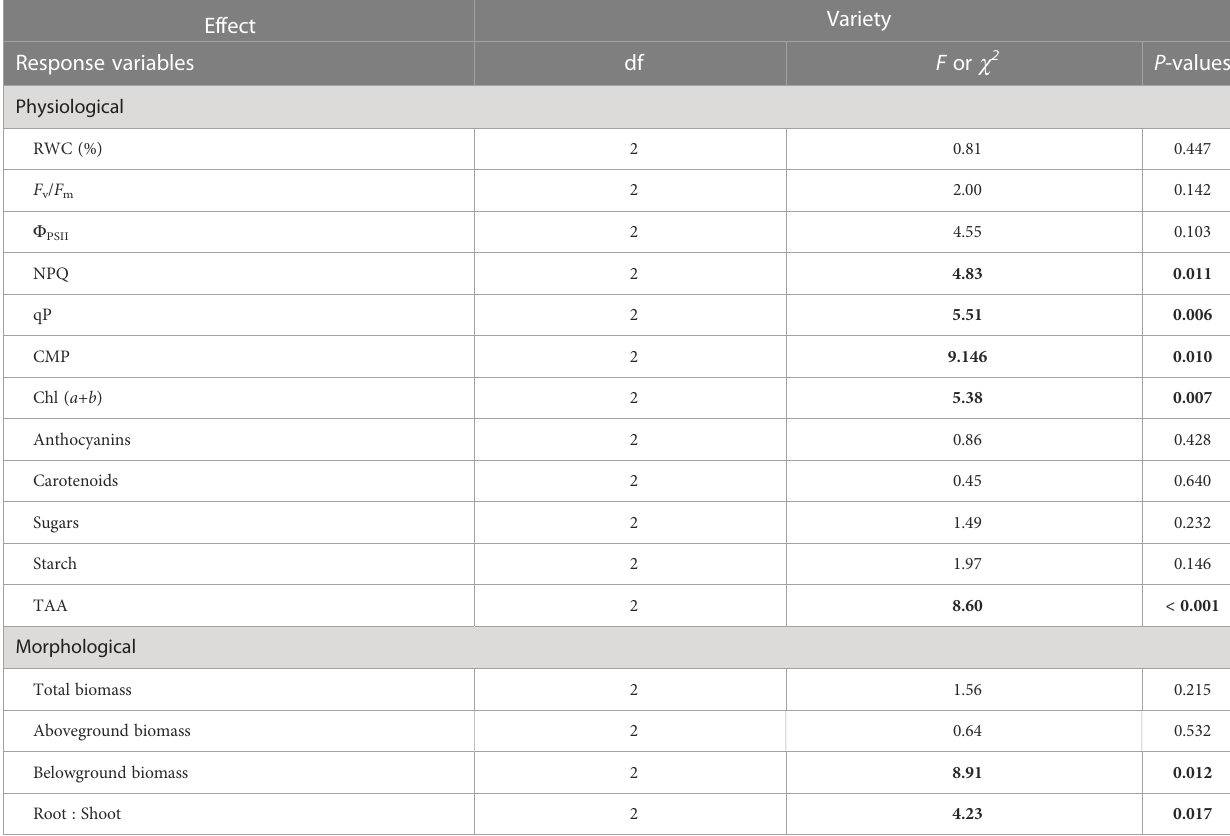
TABLE 3 Results from the one-way ANOVA or Kruskal-Wallis testing for the effect of variety (2 x var. maritima , 4 x var. maritima and 4 x var. sabularia ) on the response of morphological and physiological traits measured.